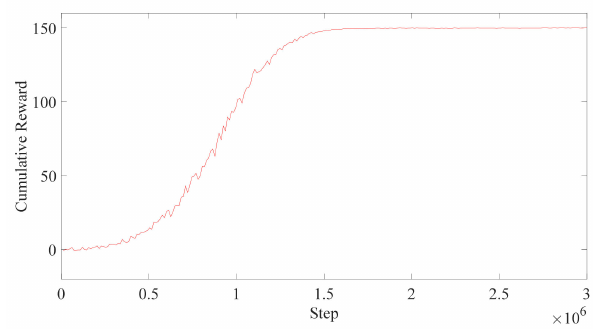
Figure 16. The training results in posture changing.